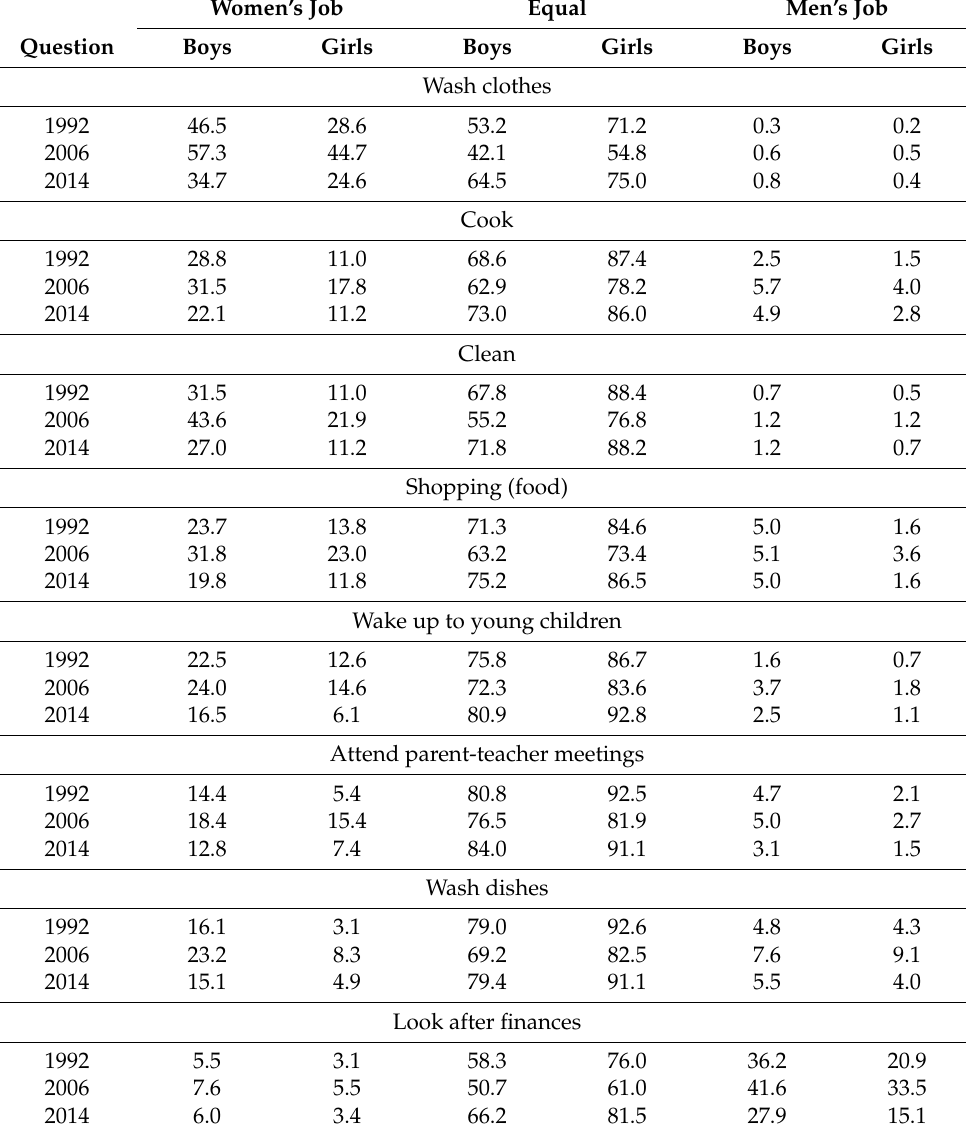
Table 2. Percentage whose job it is if both work outside the